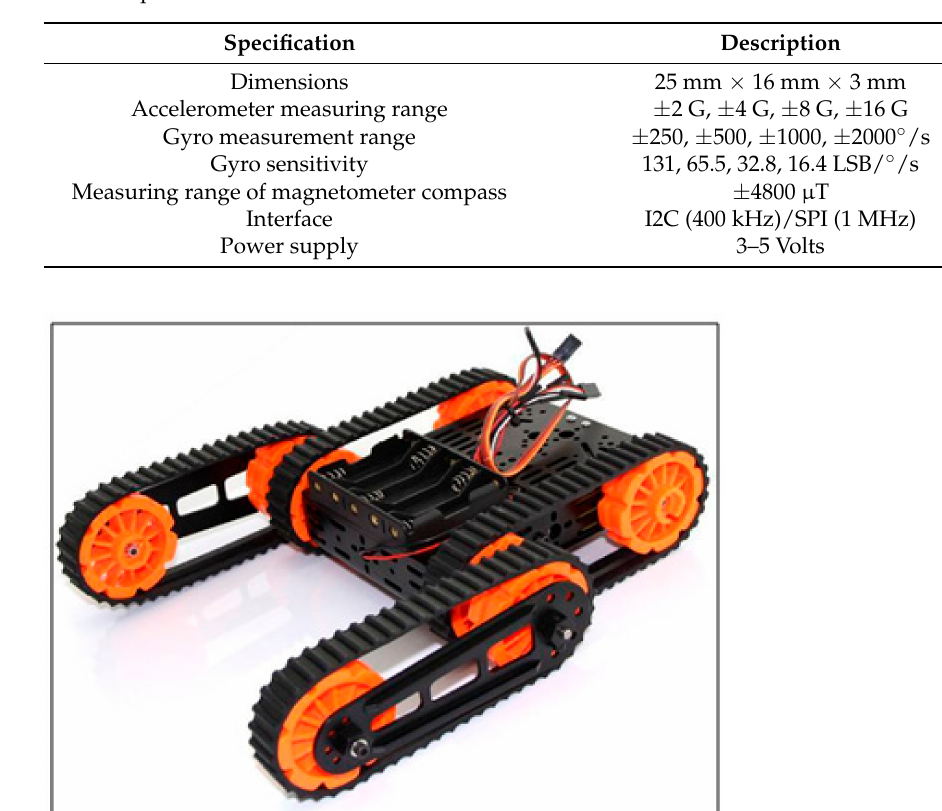
Figure 5. Inertial Sensor. Table 5. Specifications of Inertial Sensor.